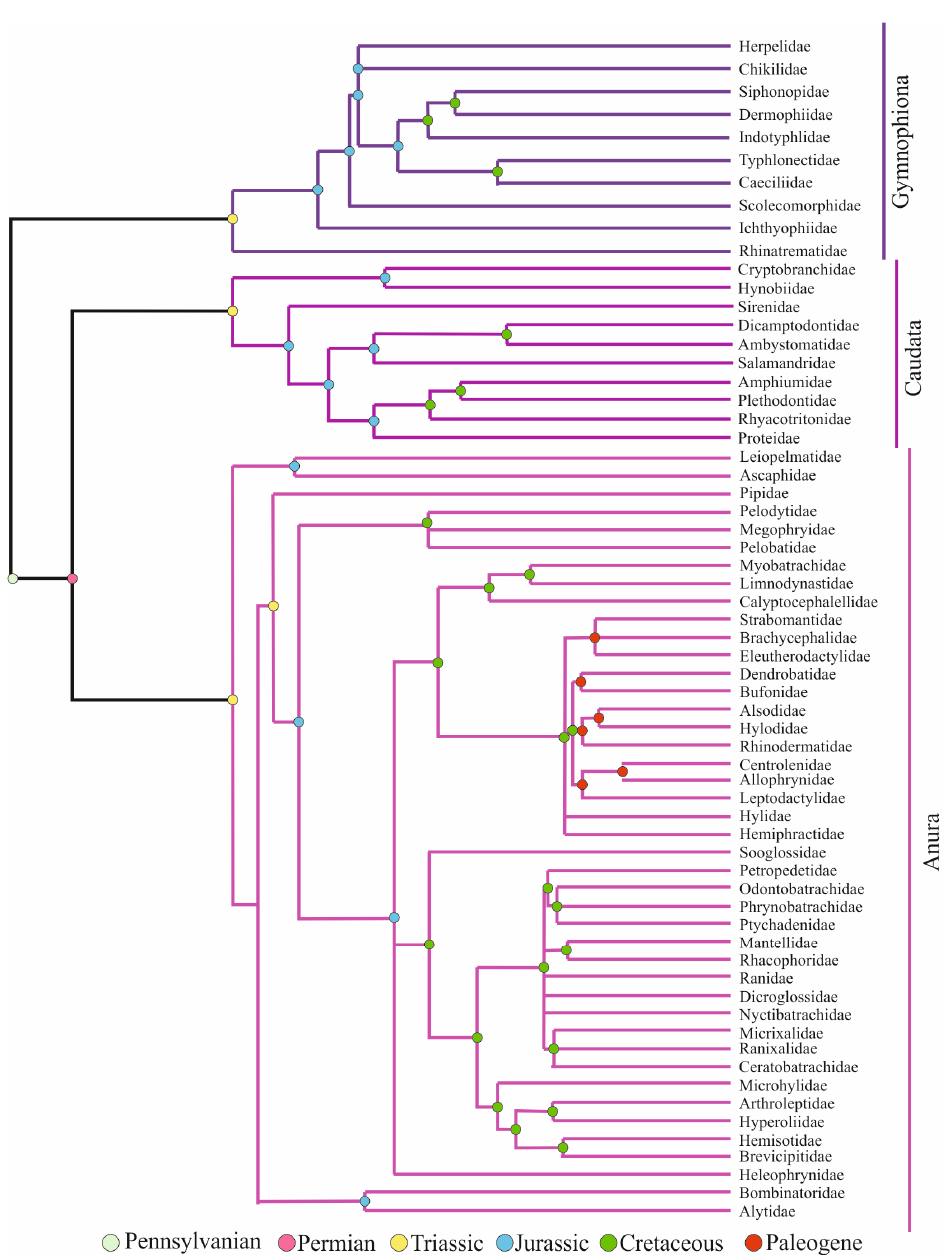
Figure 1. Evolutionary tree of amphibians (adapted from Refs. [3–6]. 2009, Cannatella, D.C. et al.; 2009, Bossuyt, F. et al.; 2009, Vieties, D.R. et al.; 2009, Gower, D.J. and Wilkinson, M.).